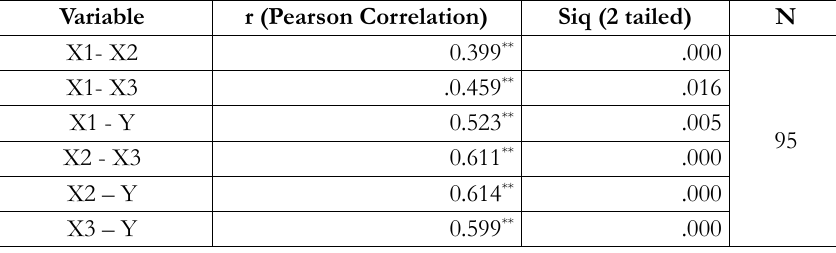
Table 3. Summary of the correlation coefficient (pearson) among variables